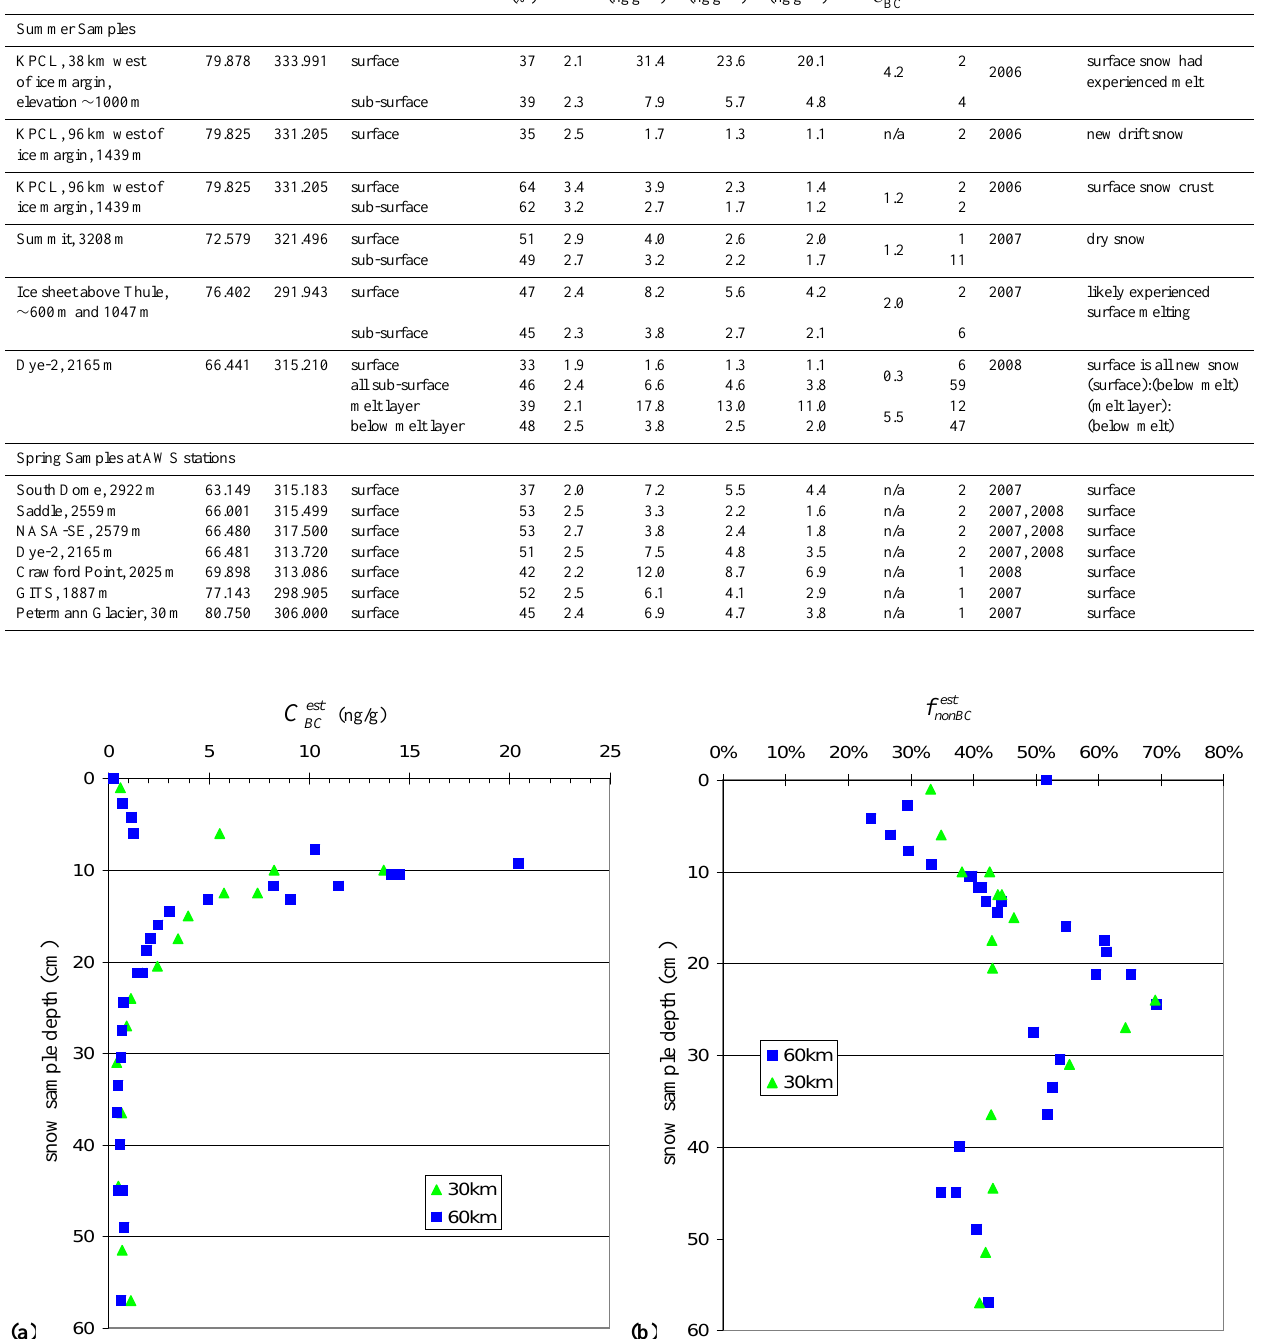
Fig. 10. Profiles of C est (left) and f est (right) for three summer-time profiles taken 30km and 60km upwind (south) of the Dye-2 station BC nonBC in